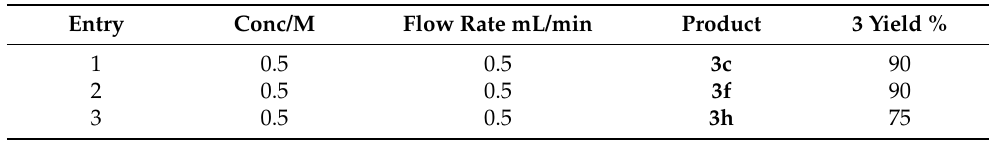
Table 3. Continuous-flow synthesis of compounds 3c , 3f and 3h using 15 cm AR-35 packed-bed columns. Collected fractions were monitored by GC-MS